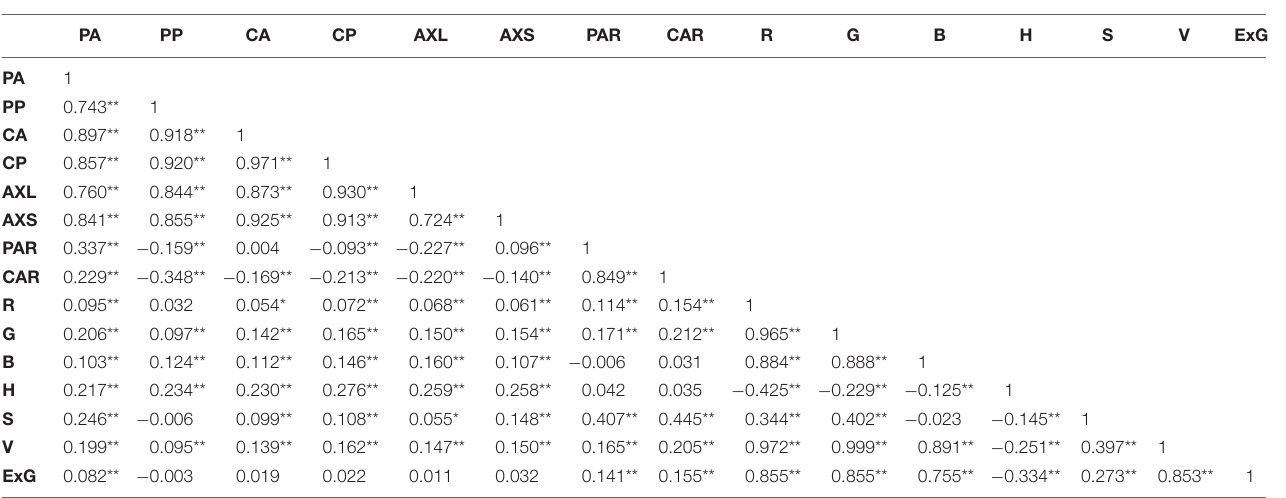
TABLE 3 | Correlation coefficients between static traits of